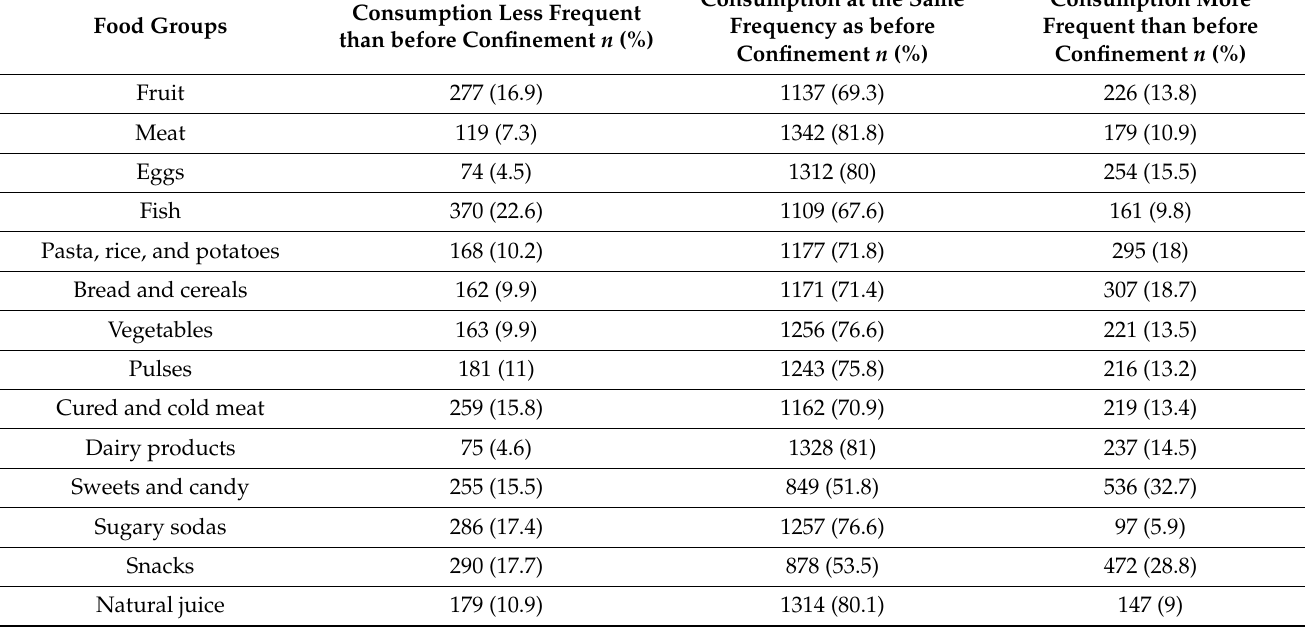
Table 3. Comparison of the consumption of food groups by the Spanish population before and during the confinement imposed during the COVID-19